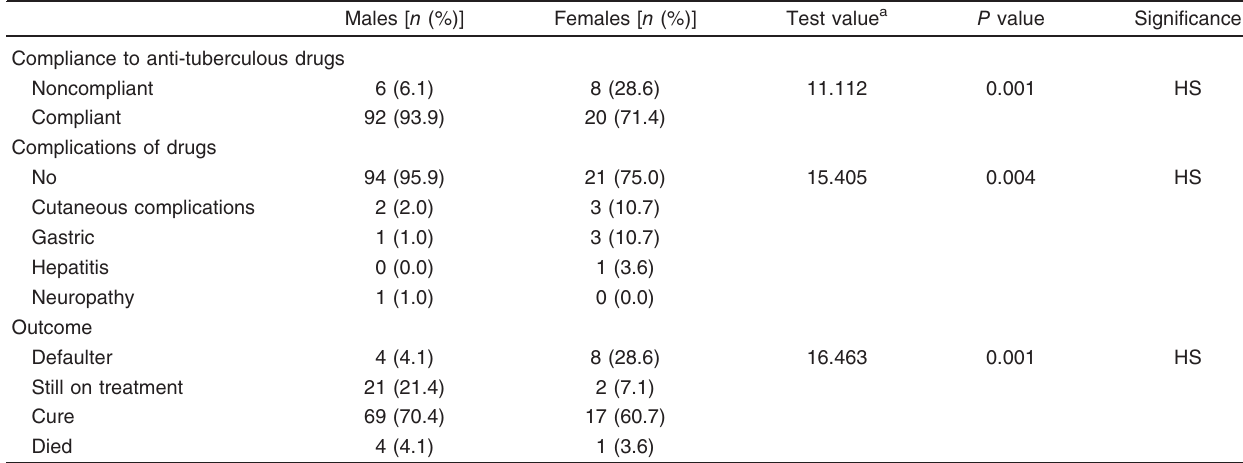
Table 6 Comparison of the follow-up period between females and